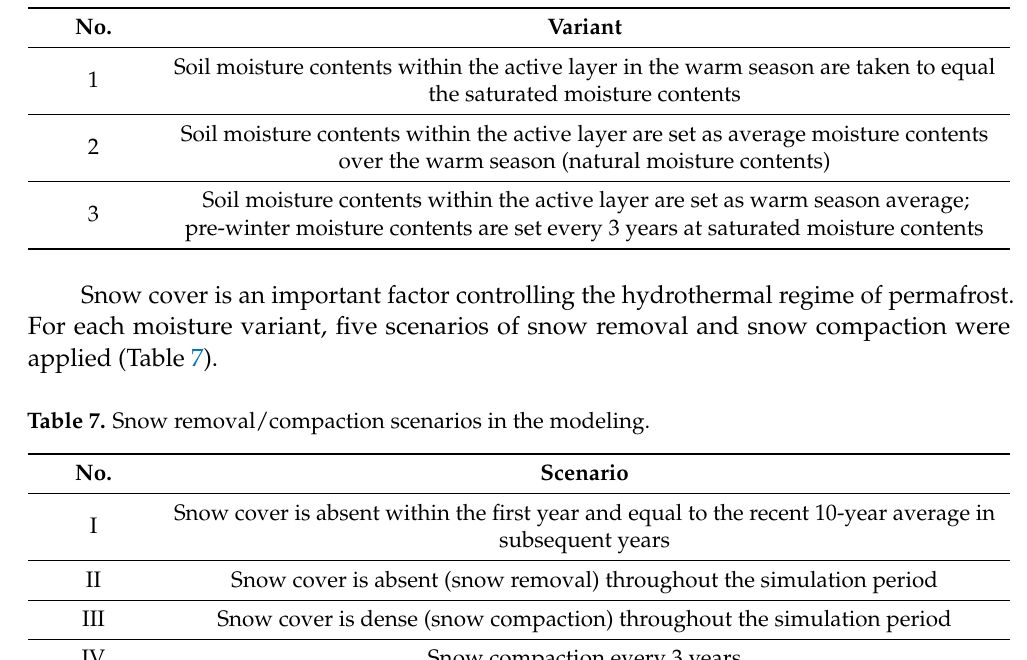
Table 5. Thermal properties of materials in the modeling. λ C γ Material Thawed Frozen Thawed Frozen Clayey silt 1.3 1.8 2,889,000 2,278,000 Sandy silt 1.47 2.4 3,488,000 2,140,000 Wedge ice - 2.6 1,890,000 Sand 1.9 2.5 1,600,000 1,400,000 Organic mat 1.2 1.8 1,500,000 1,180,000 Ice with ≤ 20% soil 1.77 2.38 1,856,000 1,301,000